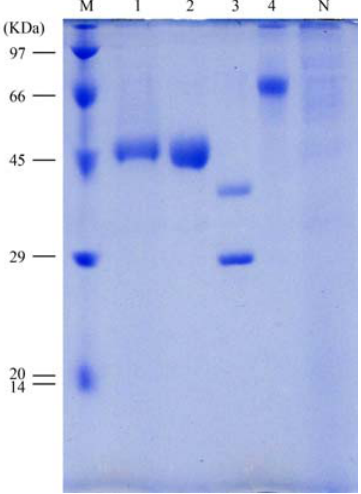
Figure 3. SDS-PAGE of the purified recombinant EGLB. SDS-PAGE of EGLB